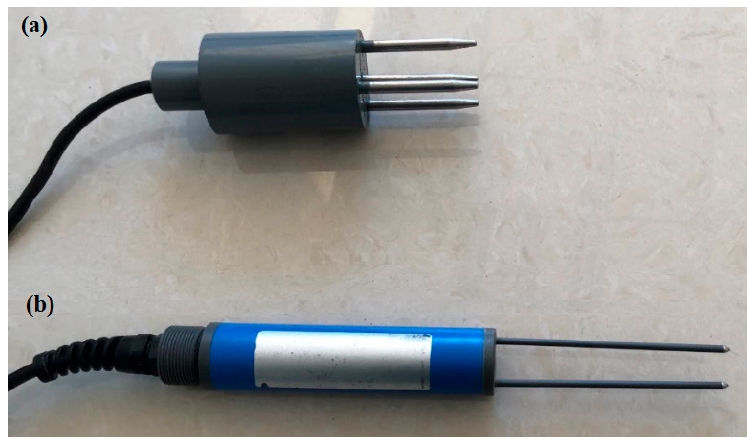
Figure 2. Photograph of the probes used: ( a ) the SWR probe; ( b ) the commercial time domain reflectometry (TDR) probe.